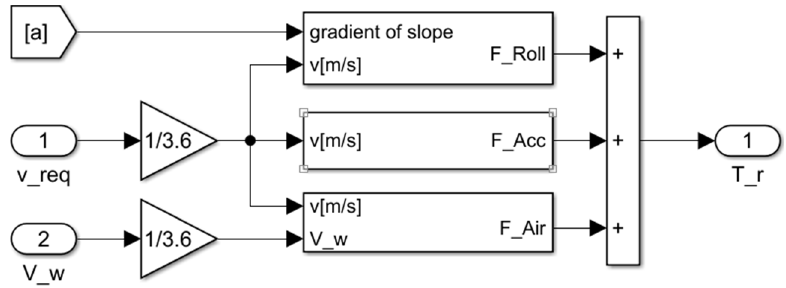
Figure 5. Speed demand torque model.